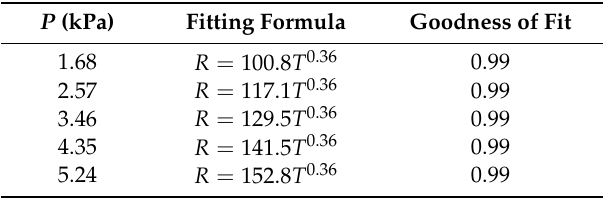
T (unit: s) is the injection time; R (unit: µ m) is the radius of the